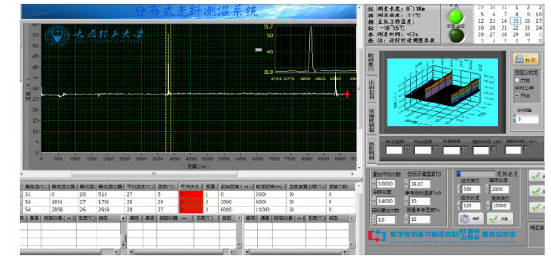
Fig. 4 RDTS platform based on LabVIEW.